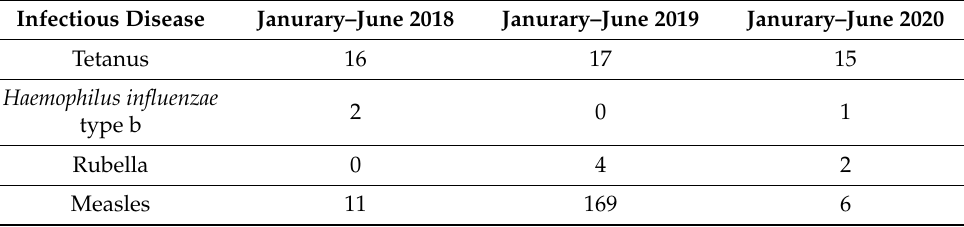
Figure 2. Vaccine-preventable disease notifications (2018–2020). The incidence of the most vaccine-preventable diseases decreased in January to June 2020 during the COVID-19 pandemic. ( A ) Varicella and mumps ( B ) invasive pneumococcal infections, pertussis, hepatitis B. Table 2. Number of vaccine-preventable disease notifications according to period. Infectious